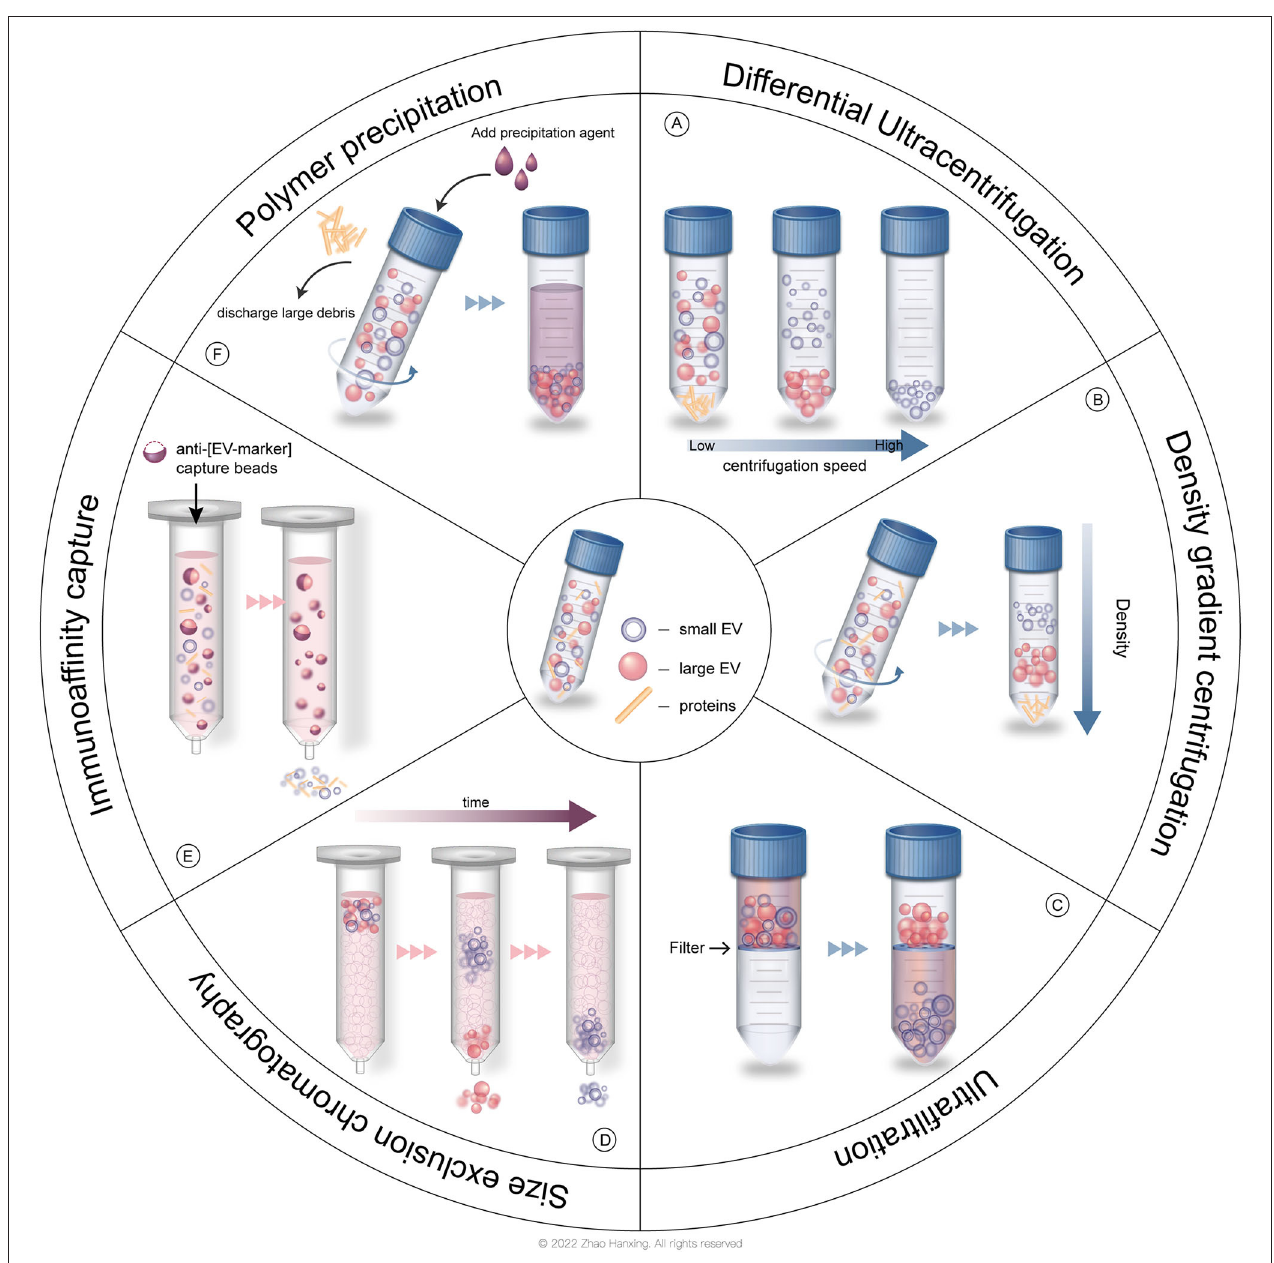
FIGURE 3 | Common isolation strategies of EVs. (A) Differential ultracentrifugation (DC). (B) Density gradient centrifugation (DGC). (C) Ultrafiltration (UF). (D) Size exclusion chromatography (SEC). (E) Immunoaffinity capture (IC). (F) Polymer precipitation